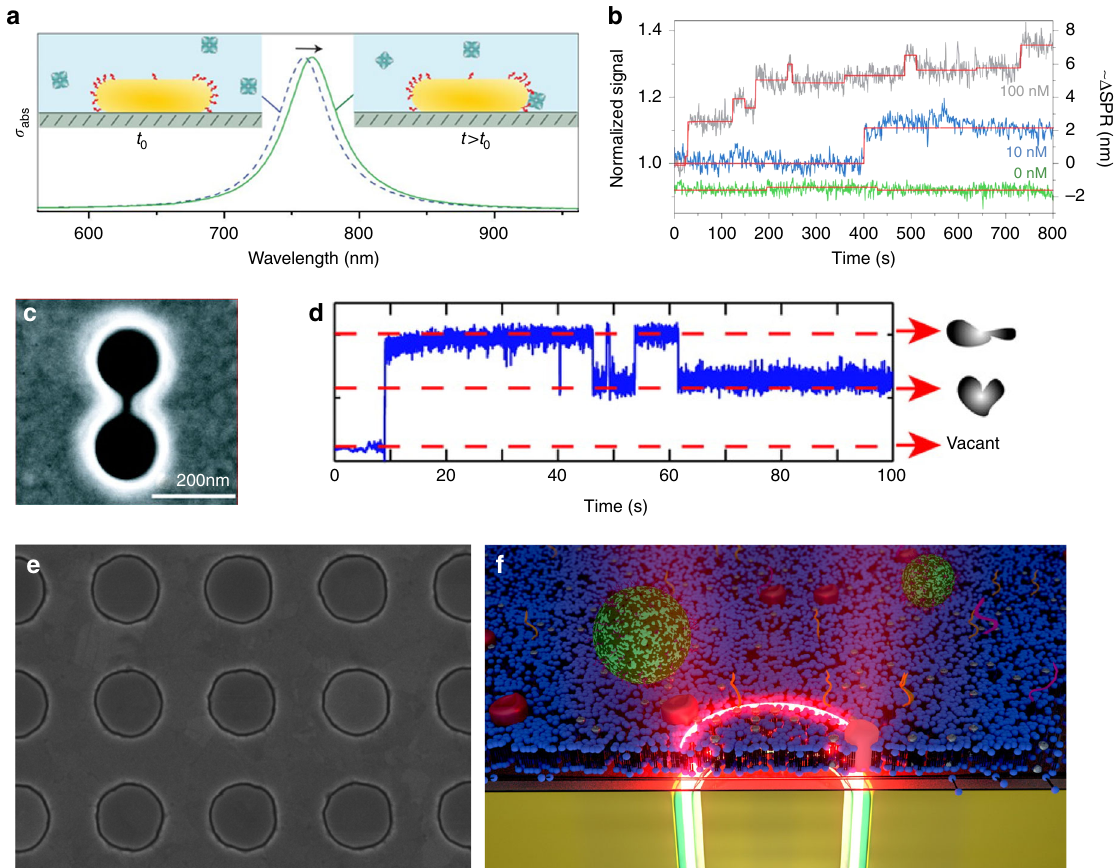
Fig. 1 Nanoparticle, tip, hole, and gap for sensing and manipulating biomolecules. a Gold nanorod for label-free plasmonic detection of a single nonabsorbing protein molecule. Reprinted from ref. 5 with permission. Copyright 2012 Springer Nature. b Time-resolved photothermal signal for biotin- functionalized gold nanorods in the presence of protein (streptavidin-R-phycoerythrin conjugate) molecules. Reprinted from ref. 5 with permission. Copyright 2012 Springer Nature. c A double-nanohole aperture was used for low-power optical trapping and label-free detection of a bovine serum albumin molecule. Reprinted from ref. 8 with permission. Copyright 2012 American Chemical Society. d A time trace of the optical power transmitted through a double-nanohole in a gold fi lm, using a solution containing protein bovine serum albumin (BSA) molecules. Reprinted from ref. 8 with permission. Copyright 2012 American Chemical Society. e High-throughput atomic layer lithography 9 technique allows large-scale fabrication of coaxial apertures with sub-10- nm gaps, which can be used for surface-enhanced spectroscopies and optical trapping. Scanning electron micrograph of an array of gold coaxial nanoapertures (250 nm diameter and 10 nm gap width). Image credit: Daehan Yoo. f By interfacing nanoplasmonic structures with fl uid biomembranes, it is possible to study dynamic interactions of lipids, proteins, and nanovesicles. This illustration shows a proposed scheme of optically trapping a single membrane protein molecule in a supported lipid bilayer membrane. Image credit: Christopher T.